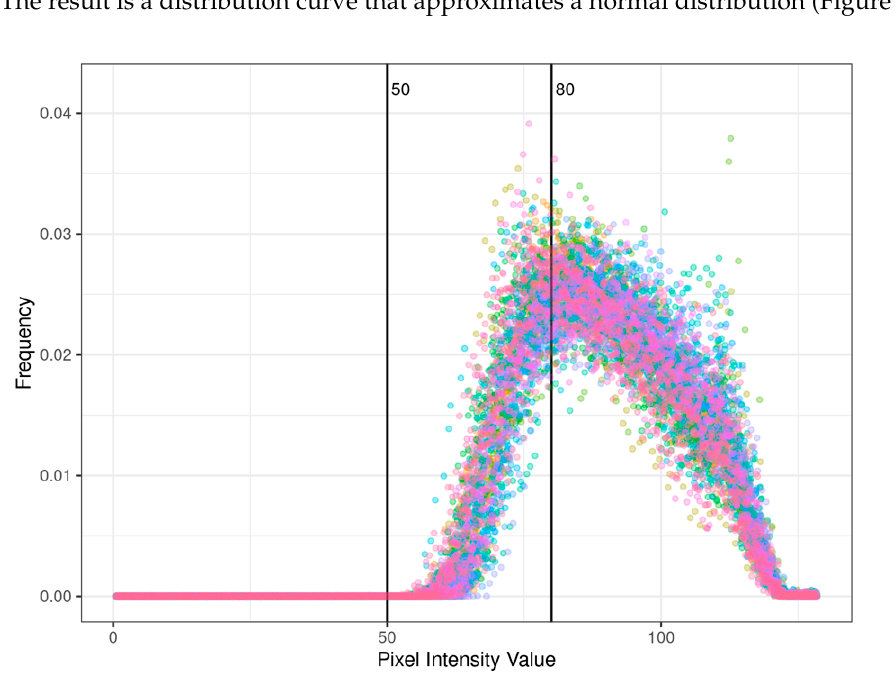
Figure 2. Cumulative readings of pixel intensity values of all SSD genotypes under water stress.